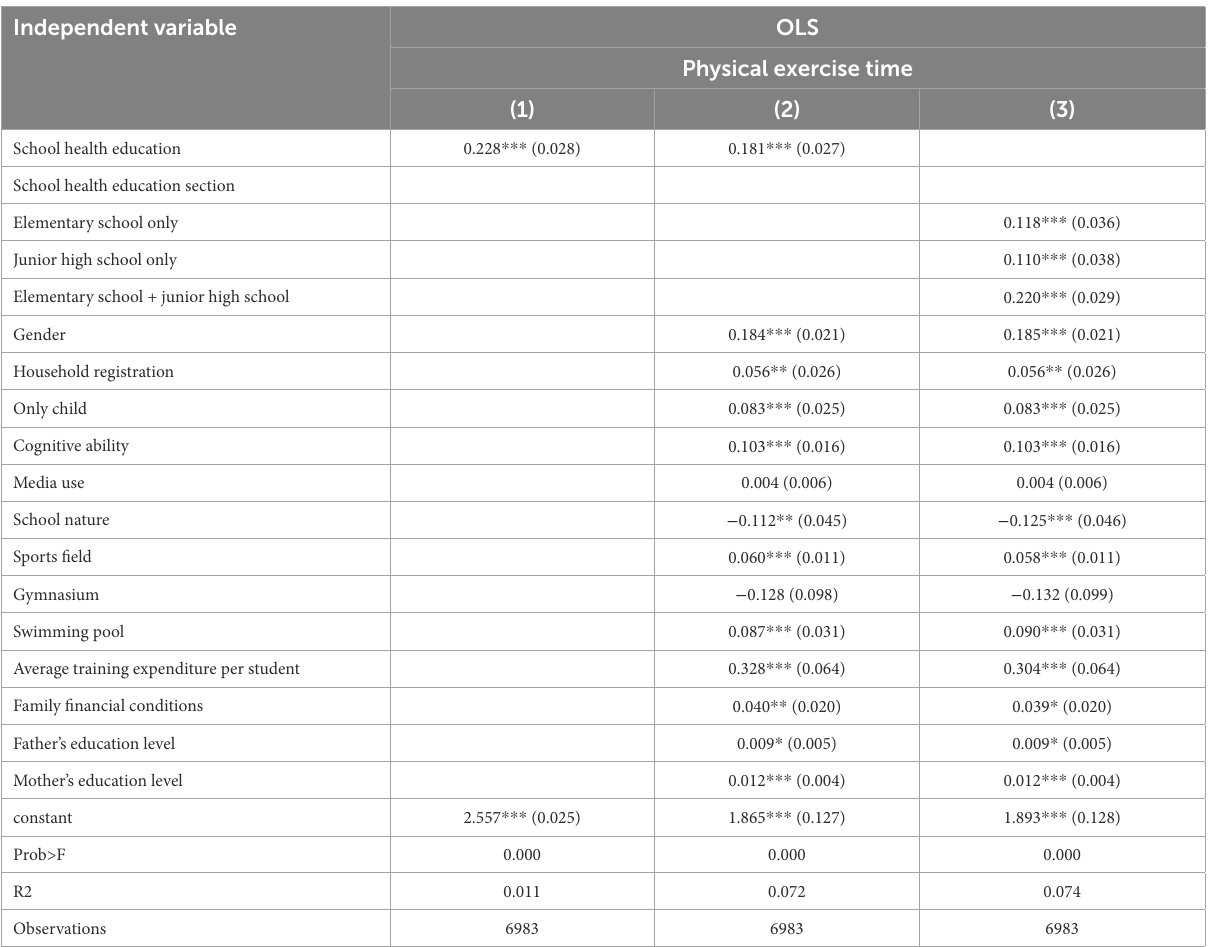
TABLE 2 The impact of school health education on students’ physical exercise. Independent variable